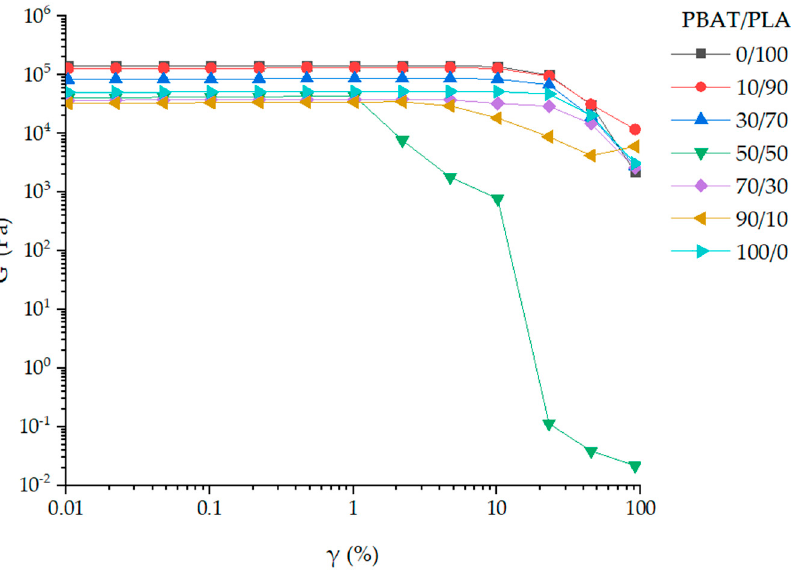
Figure 3. Amplitude sweep tests of PBAT/PLA melts, neat PBAT and PLA as control samples at 160